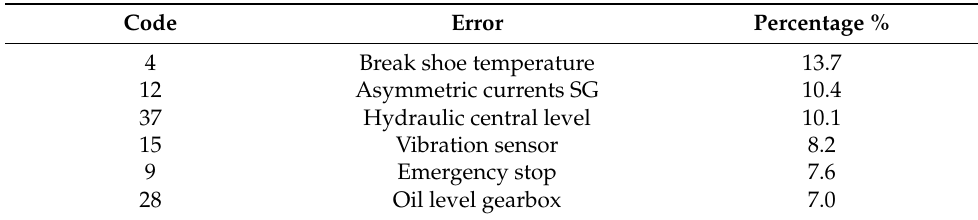
Table 2. Errors with the more important percentage of time lost respect the total stoppage